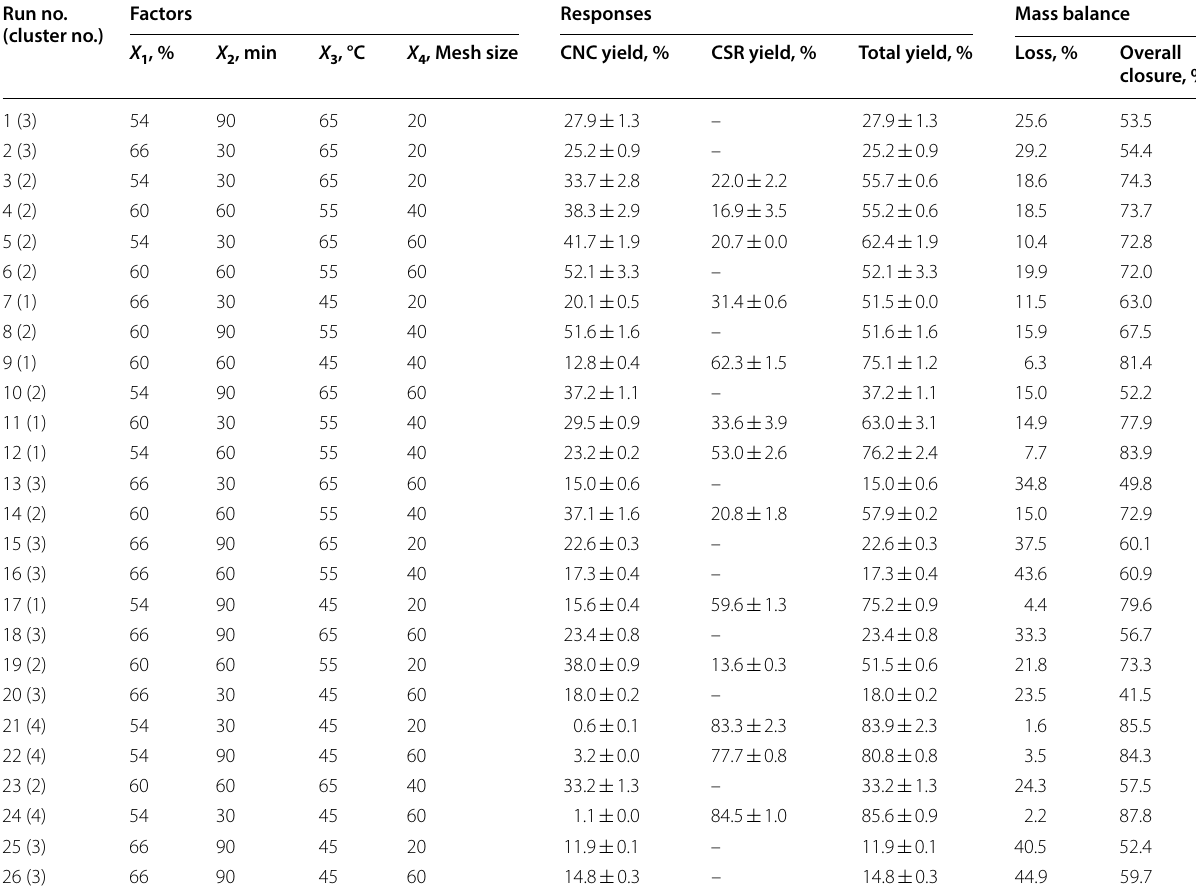
% Total yield is the sum of CNC and CSR yields. % Loss is the total carbohydrate (cellulose and hemicellulose) lost in the first waste stream in the form of monosaccharides. Yields, losses and overall mass closure are expressed as a % of the initial dry weight of kraft pulp